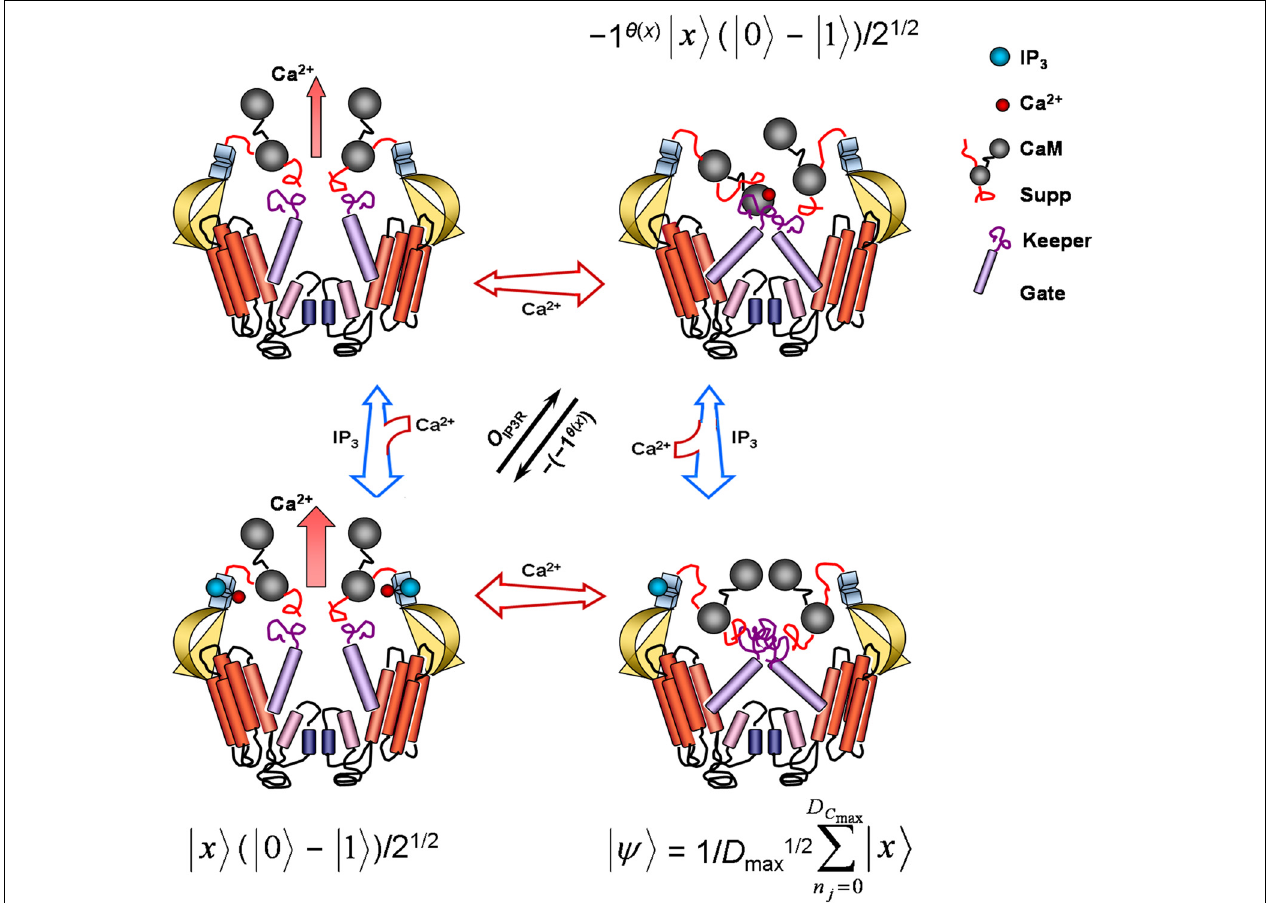
FIGURE 2 | Model of conformation, ion permeability, and corresponding Grover’s quantum-algorithm function of an inositol 1,4,5-trisphosphate receptor channel (IP 3 R). Each cross-section contains two of four complete IP 3 R subunits. When only cytosolic IP 3 (blue sphere) binds, the receptor lumen stays closed and inactive. Cobinding of cytosolic IP 3 and Ca 2 + (red sphere) to separate high-affinity sites proximal to the IP 3 -binding domain dissociates suppressor (Suppr), calmodulin (CaM), and gatekeeper (Keeper) regions, repositioning the transmembrane gate (Gate) and activating Ca 2 + conductance. In absence of IP 3 binding, low-affinity binding of cytosolic Ca 2 + to one of two calmodulin heads occludes the ion channel as calmodulin crosslinks with suppressor and gatekeeper regions of adjacent receptor subunit. No ligand binding is accompanied by a small leaking Ca 2 + conductance. Free cytosolic proteins, nucleotides, and other substances can facilitate or impair IP 3 R gating by interacting with the IP 3 binding-core,